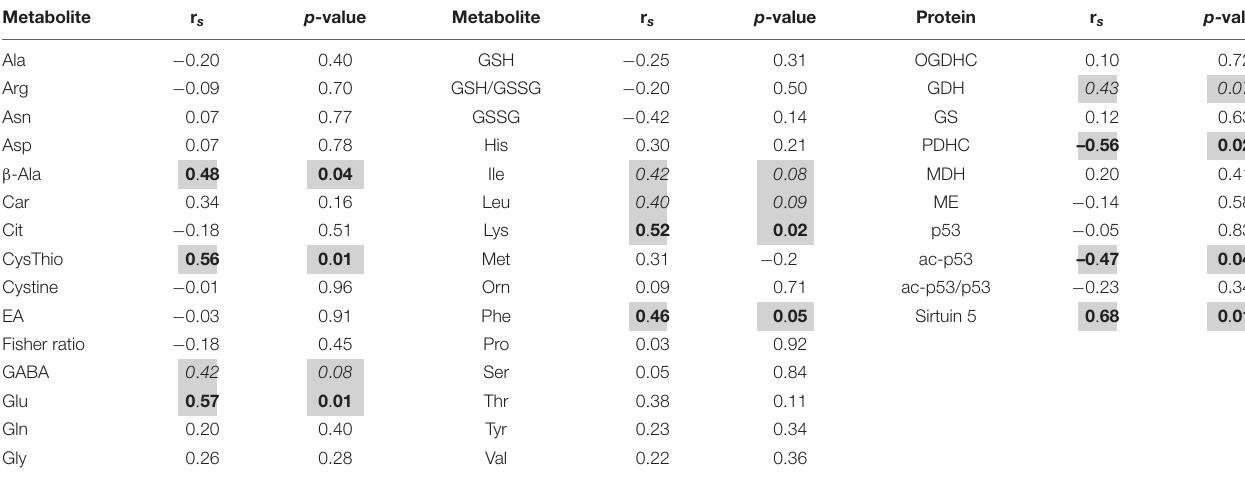
FIGURE 4 | Reactivities of OGDHC and affiliated enzymes to the post-operative administration of the OGDHC pro-inhibitor TEGP in the SCI or LE rats. (A) The enzymatic activities in the spinal cord (SpC); (B) The enzymatic activities in the cerebral cortex (Cor); (C) Significances ( p ≤ 0.05, in bold) and trends (0.05 < p ≤ 0.1, in italic) of the SCI and TEGP factors and their interactions, according to the two-way ANOVA of the data in (A,B) , are highlighted in gray. TEGP is administered intranasally at a dose of 0.02 mmol/kg within 24 h after operation. On the graphs, different p -values are shown by asterisks as described in Methods under Statistical Analysis. Number of animals in each group: LE, n = 5; SCI, n ≥ 5; LE + TEGP, n = 6; SCI + TEGP, n = 5. TABLE 2 | Correlations between the level of locomotor recovery of rats 8 weeks after SCI and metabolites in the cerebral